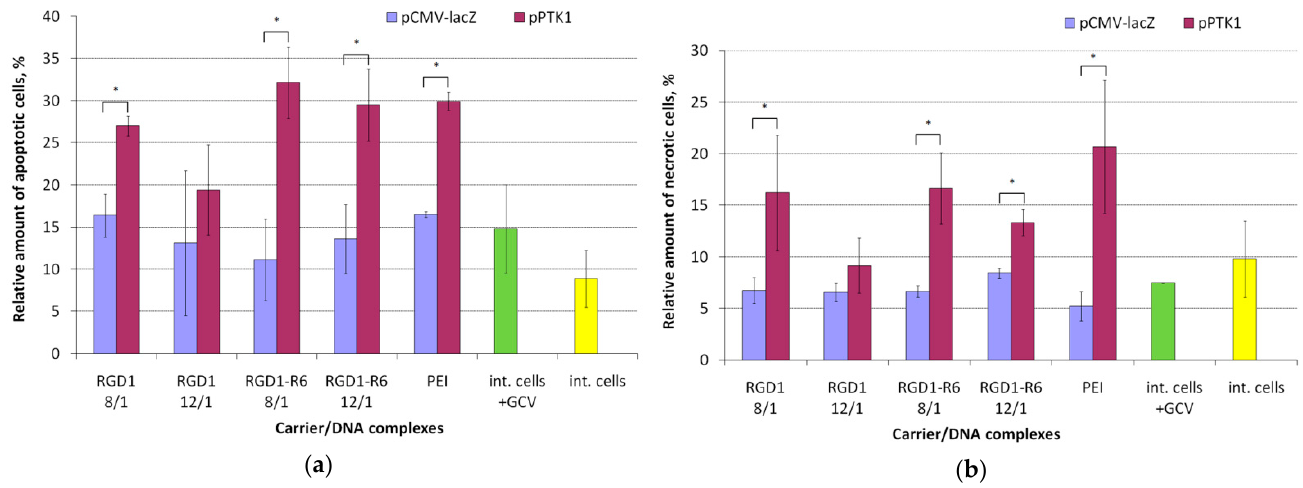
Figure 11. Apoptosis ( a ) and necrosis ( b ) of UL cells induced by GCV treatment after cell transfection with RGD1-R6/DNA or RGD1/DNA polyplexes formed with pPTK and pCMV-lacZ plasmids. Values are the mean ± SEM of the mean of four independent experiments. * p < 0.05 compared to pCMV-lacZ-complexes.